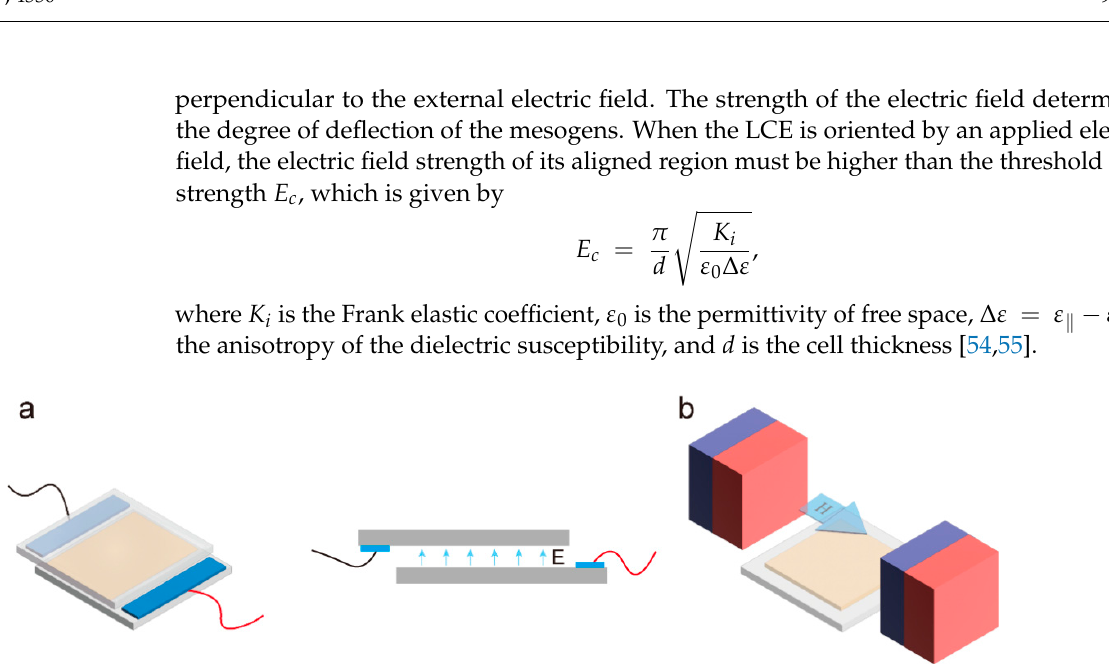
Figure 6. ( a ) Schematic representation of LCE alignment by electric field. ( b ) Schematic representation of LCE alignment by magnetic field.